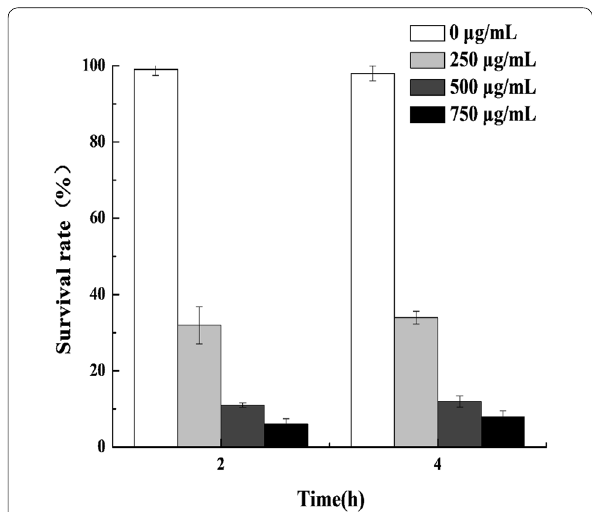
Fig. 1 Vitality of the S. aureus treated by ε-PL at different treatment